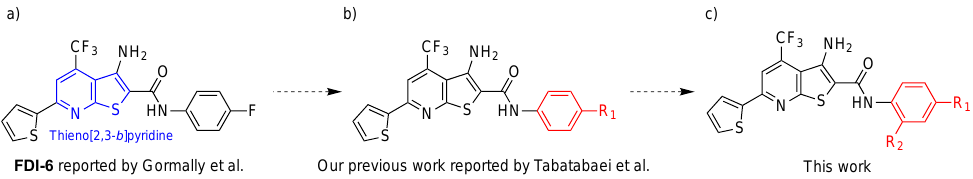
Figure 3. Previous work that led to the design of the compounds presented in this work. ( a ) FDI-6, a thieno[2,3- b ]pyridine, previously reported by Gormally et al. [8] as a direct FOXM1 inhibitor; ( b ) Previous FDI-6 derivatives reported by our research group [9]; ( c ) Compounds studied in this work.